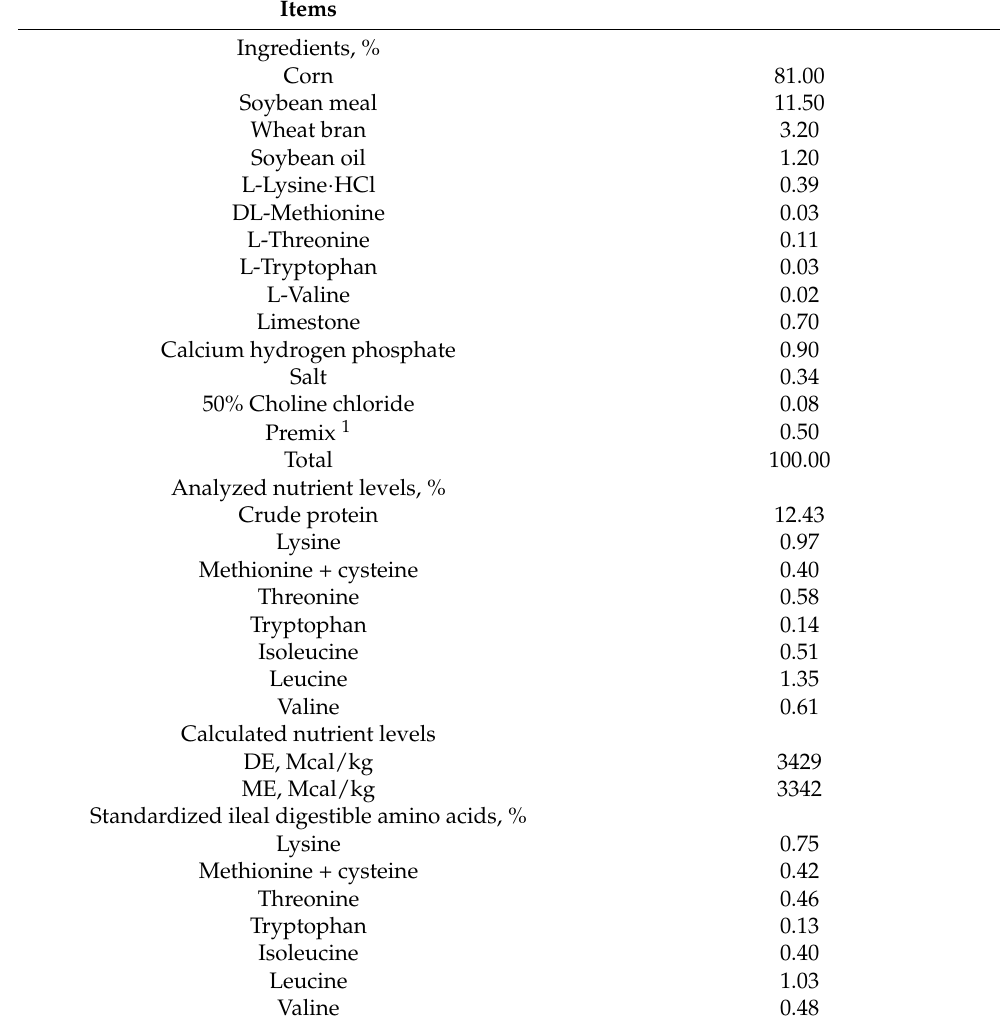
Table 1. Ingredients and nutrient levels of diets (%, as-fed